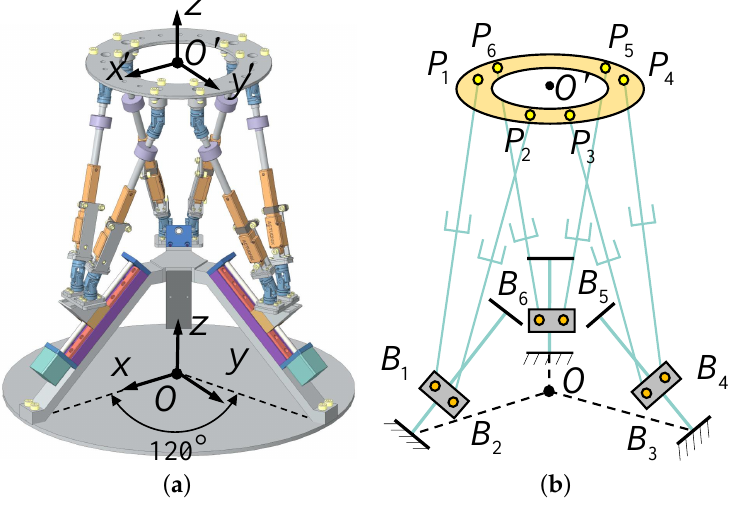
Figure 1. Redundant parallel robot with inclined rail. ( a ) 3D model. ( b ) Diagram of